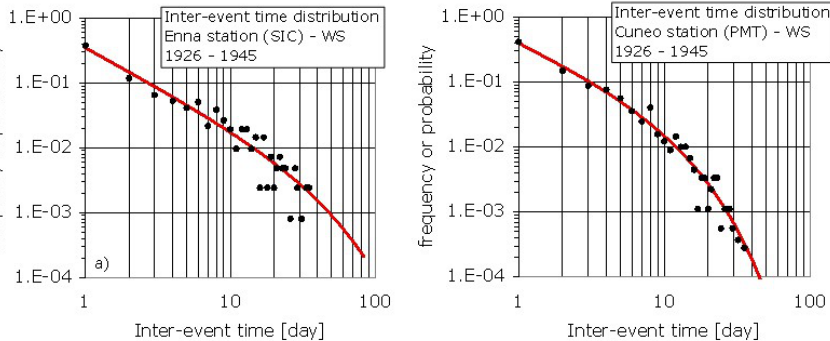
Figure 2. Fitting frequency distribution of inter-event times, T , with the polylog-series distribution, for the warm season and for Enna (SIC – left panel) and Cuneo stations (PMT – right panel). Sample data refer to the period